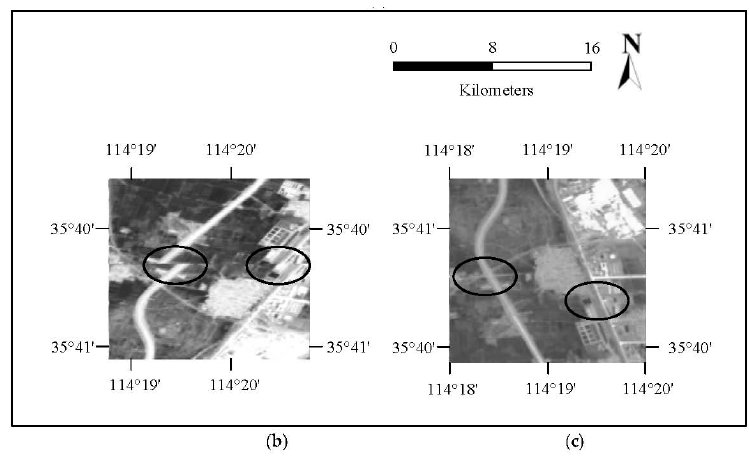
Figure 12. The mosaic result of four image sequences: ( a ) Panorama mosaic image after geometric calibration; ( b ) local mosaic result of original images; ( c ) local mosaic result after geometric calibration.